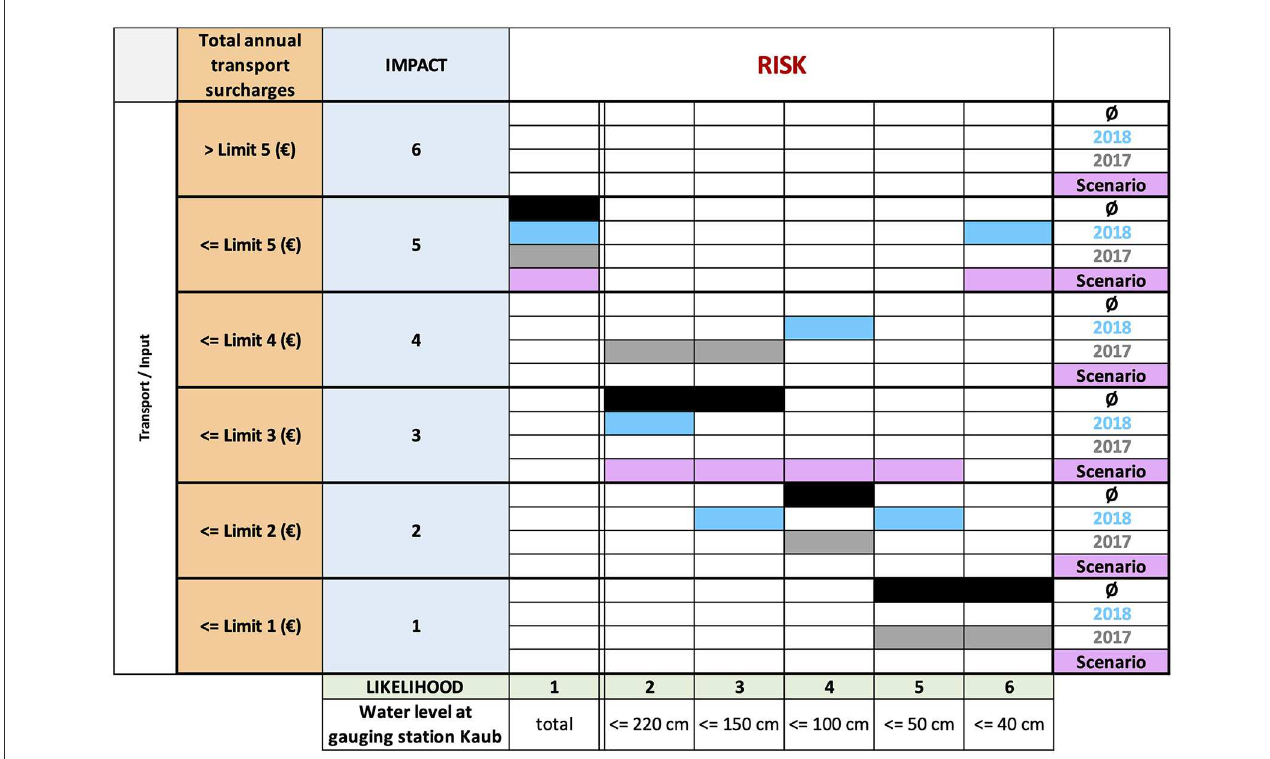
FIGURE7 Risk matrix for transport surcharges per low water days in water level interval, i.e., likelihood based on frequency, and annual surcharges (impact). The colored matrix cells indicate the magnitude of the surcharge total per water level interval wli j , j ∈{ 2, ... , 6 } , (“likelihood” class) for each of the 4 years (historic average year Ø, 2017, 2018, and a fictive “Scenario” year). The additional column for “likelihood” class 1 is not related to a specific water level interval but indicates the total impacts for each of the four